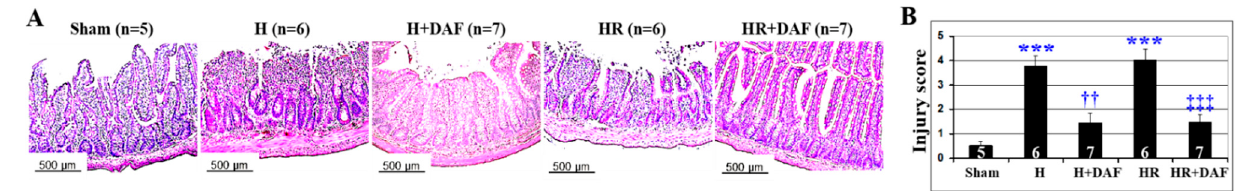
Figure 6. DAF mitigates hemorrhage-mediated small intestinal injury in rats. Representative histo- logical alterations are presented. ( A ) Histological injury scores for the small intestine of rats. ( B ) The numbers (5, 6, 7) in the figure mark the number of samples. Original magnification ×200. Scale bar = 500 μ m. *** p < 0.001 vs. sham; †† p < 0.01 vs. H; ‡‡‡ p < 0.001 vs. HR (one ‒ way ANOVA followed by Tukey’s test).